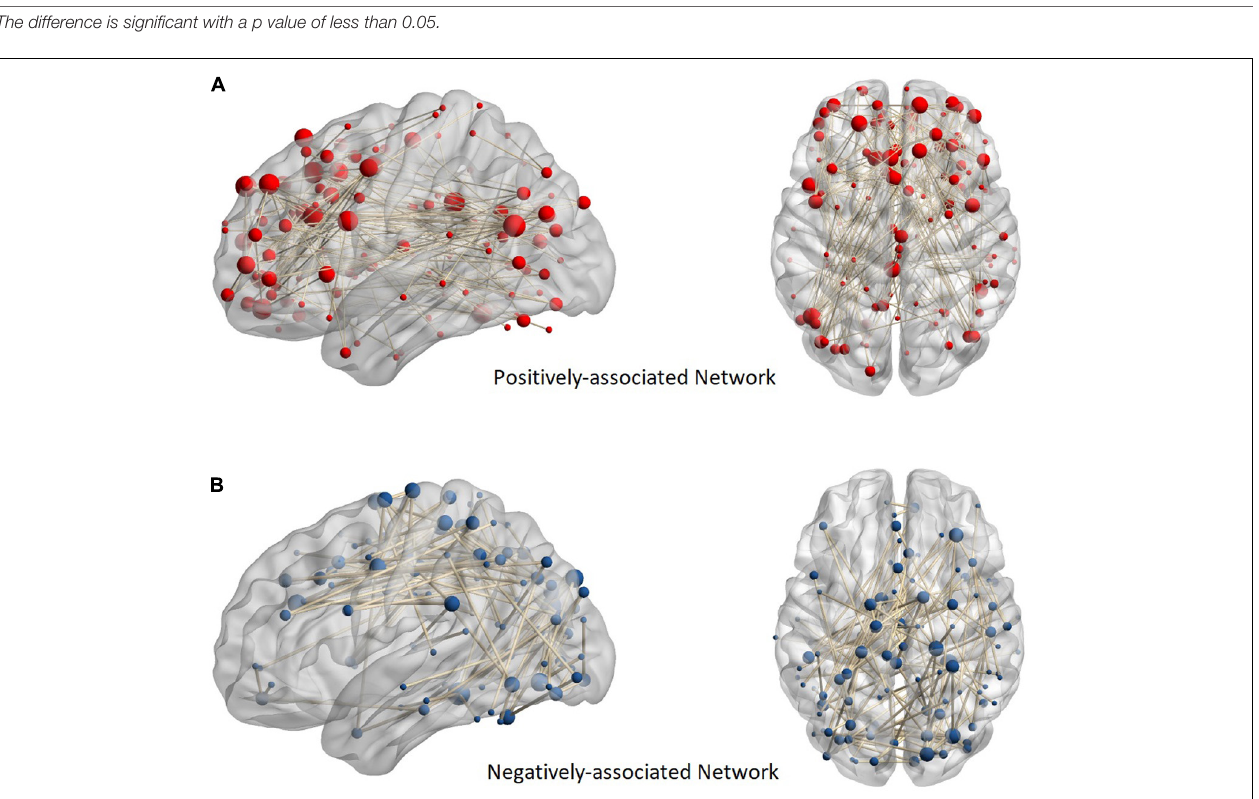
FIGURE 1 | Anatomical distribution of positive and negative networks. Panel (A) shows a positively associated network and (B) shows a negatively associated network. The sphere in the figure represents the brain region. In addition, the more edges connected to the brain region, the larger the ball. The nodes of the positive network are focused on the frontal, temporal, and limbic systems, while those of the negative network are focused on the parietal and occipital